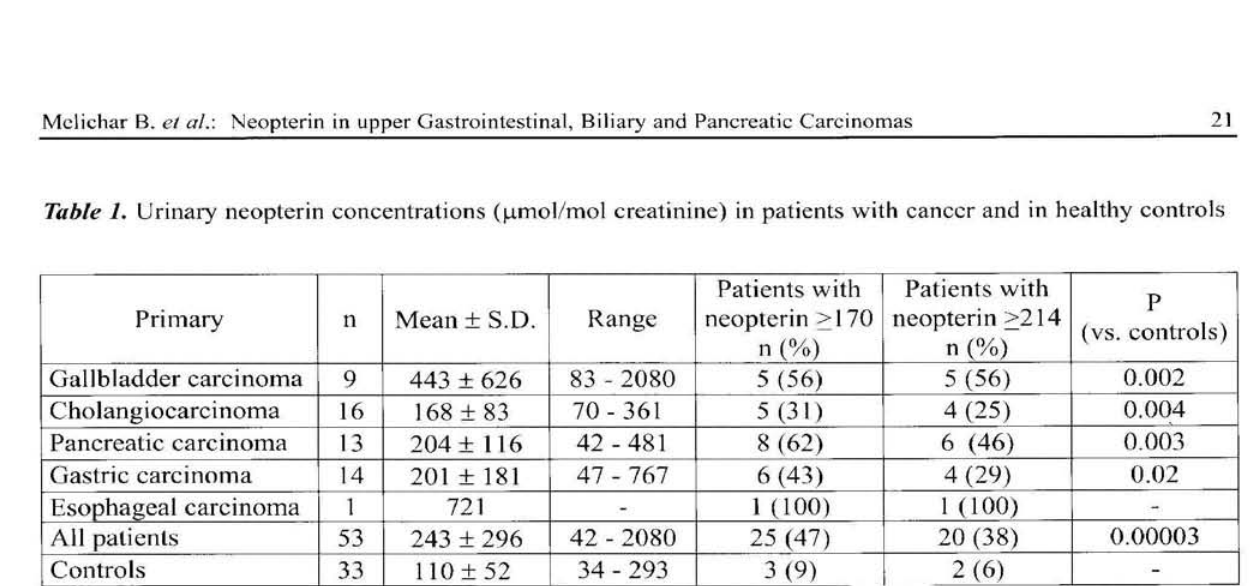
Patients with Patients with neopterin >214 neopterin >170 (vs. controls) n (%)